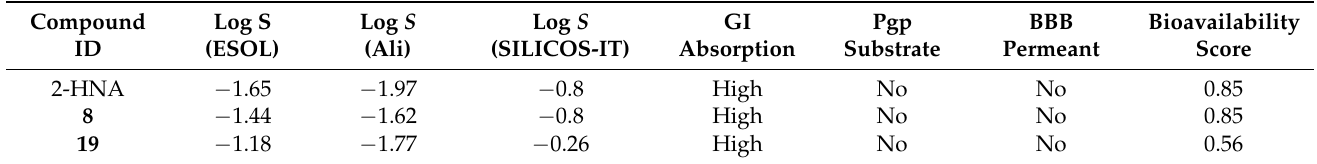
Table 4. Predicted water solubility and additional pharmacokinetic properties of the two most promising putative NAPRT